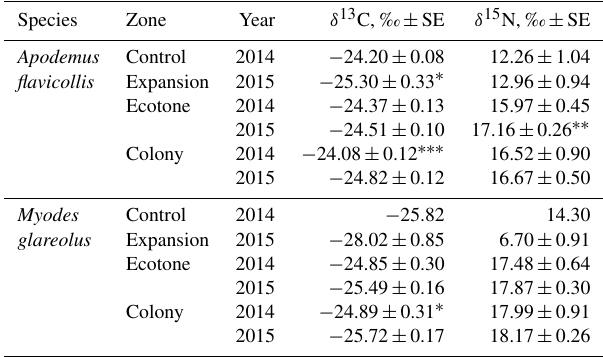
Table 2. Central position (mean ± SE, ‰) of stable isotope ratios in the hair of Apodemus flavicollis and Myodes glareolus trapped in the Juodkrant˙e colony of great cormorants. Data for 2014 recalcu- lated from Balˇciauskas et al. (2016). Significance of differences ac- cording to the Hotelling T 2 multivariate test, ∗ p <0.1, ∗∗ p <0.05, ∗∗∗ p